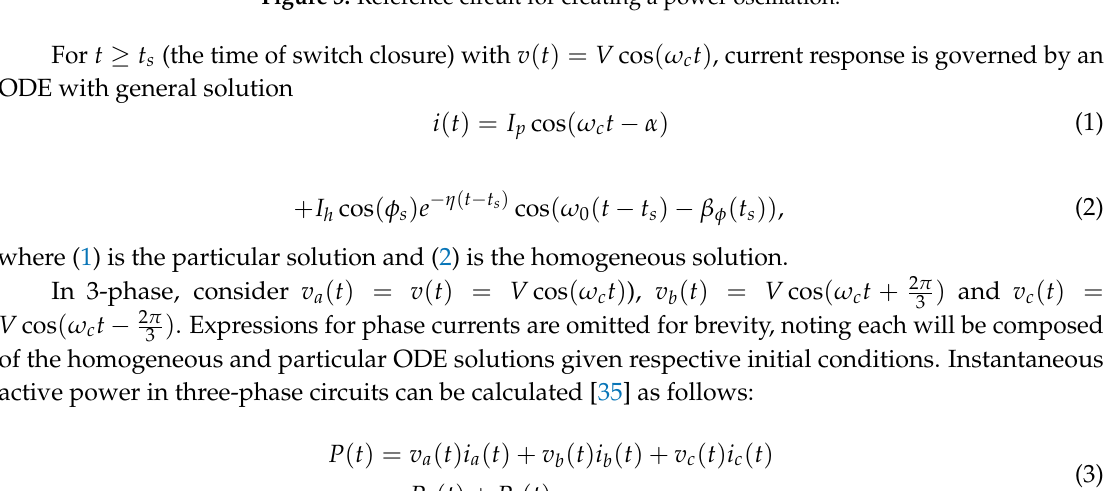
Figure 3. Reference circuit for creating a power